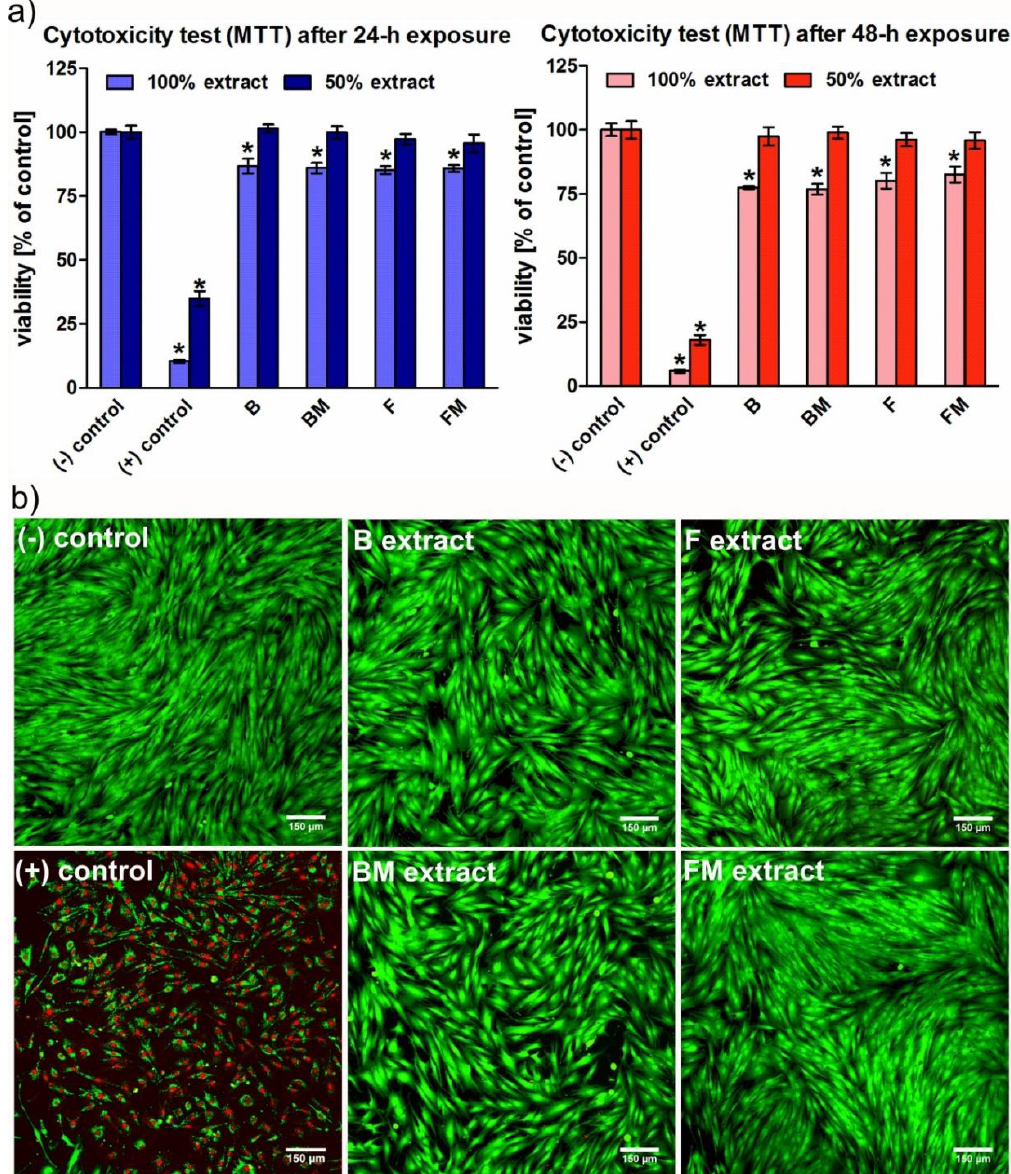
Figure 7. Cytotoxicity of the materials’ extracts assessed according to ISO 10993-5 standard by: ( a )—MTT test ( * significantly different results compared to the negative control of cytotoxicity according to one-way ANOVA test followed by Tukey’s multiple comparison test, p < 0.05; (−) control: cells maintained in culture medium, revealing 100% viability, (+) control:cells exposed to latex extract with reduced viability) and ( b )—live/dead double staining performed after 48-h exposure to the extracts (viable cells—green fluorescence, dead cells—red fluorescence; (−) control—cells maintained in culture medium, revealing 100% viability, (+) control: cells exposed to latex extract with reduced viability; 100× magnification, scale bar = 150 µm).